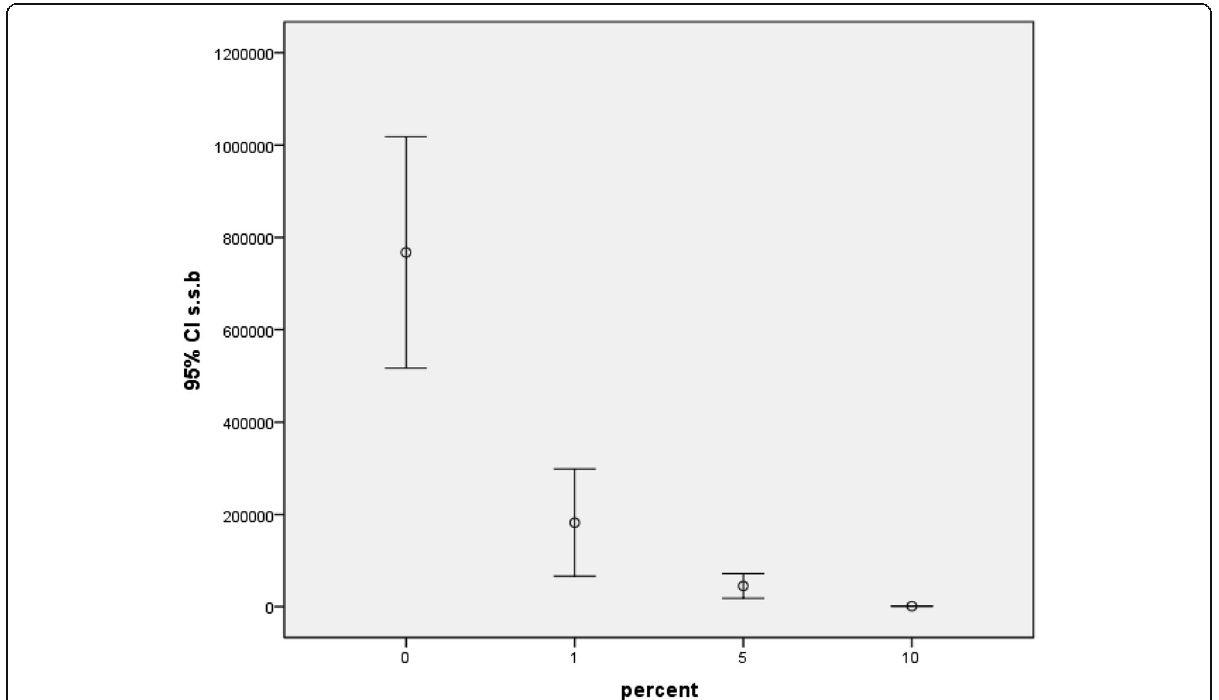
Fig. 4 Viable counts of S. sanguinis biofilms on composite discs containing 0, 1, 5, and 10 % Ag/HA nanoparticles